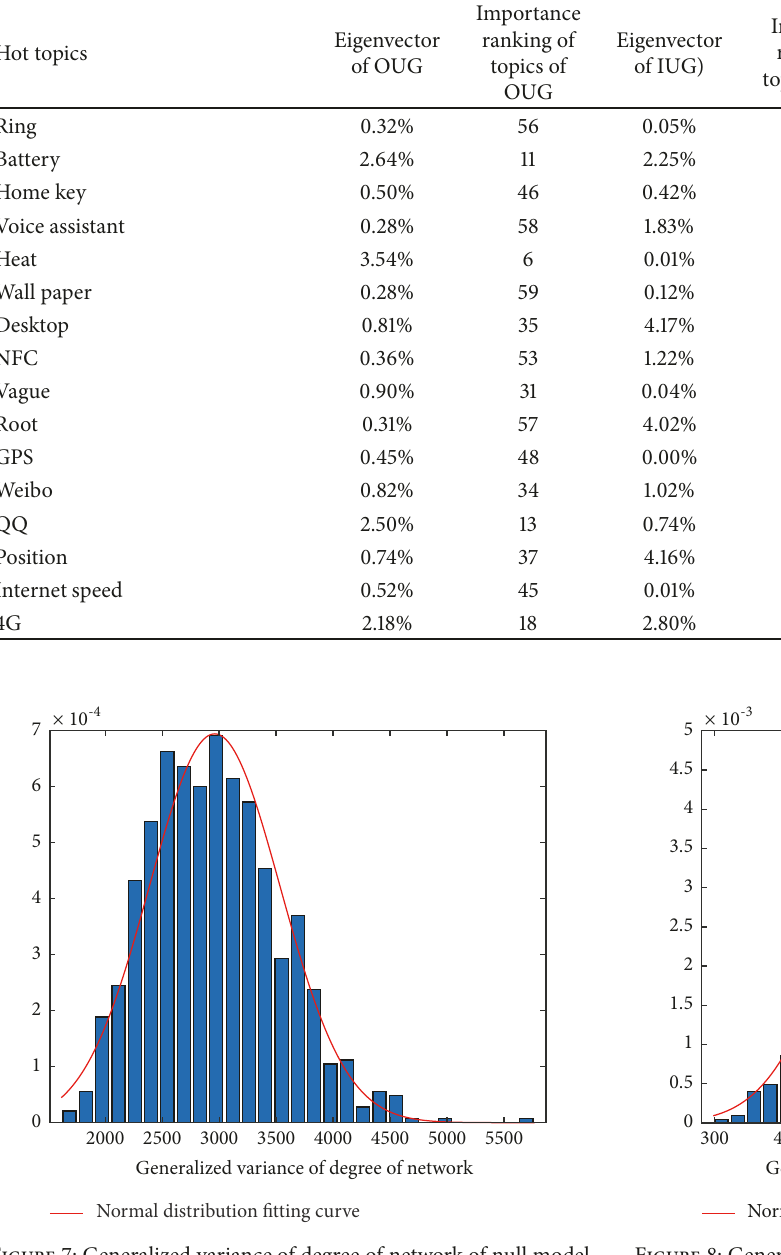
Figure 8: Generalized variance of degree of network of null model of